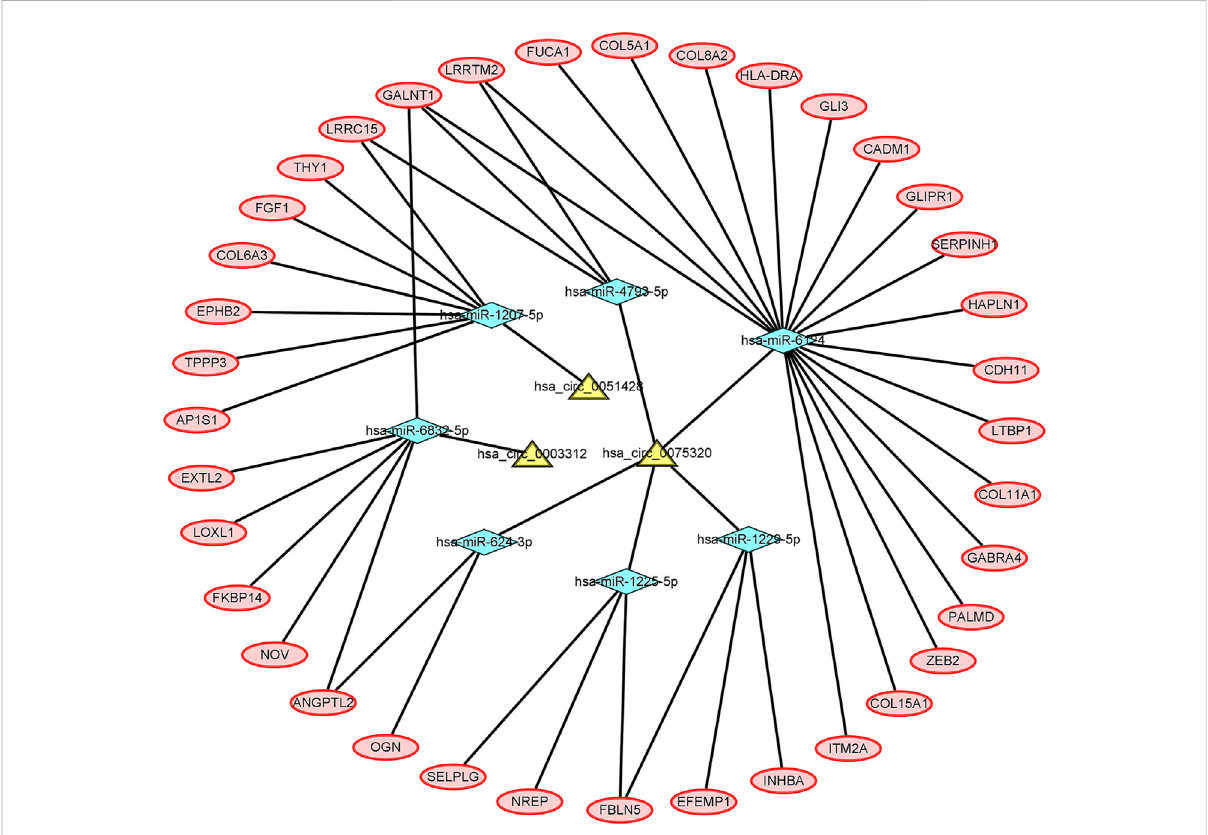
FIGURE 3 The circRNA – miRNA – mRNA network. The yellow nodes represent thecircRNAs, theblue nodesrepresent theIDEmiRNAs,and the pink nodes represent the